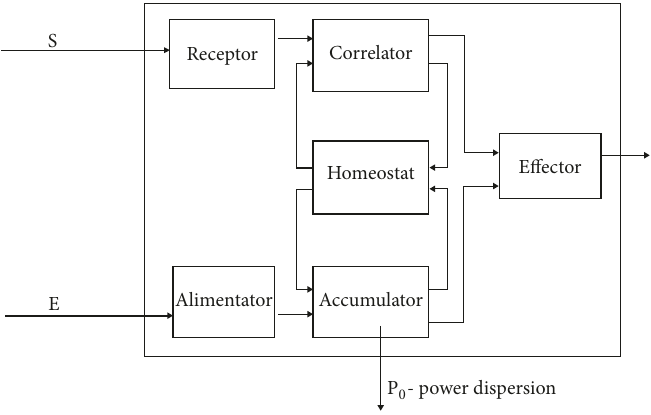
Figure 2: Cybernetic scheme of the autonomous